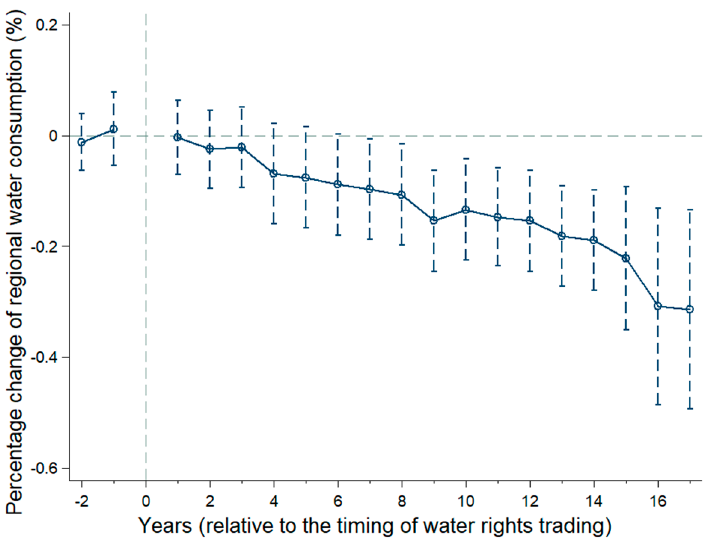
Figure 2. The dynamic impact of water rights trading on regional water consumption.